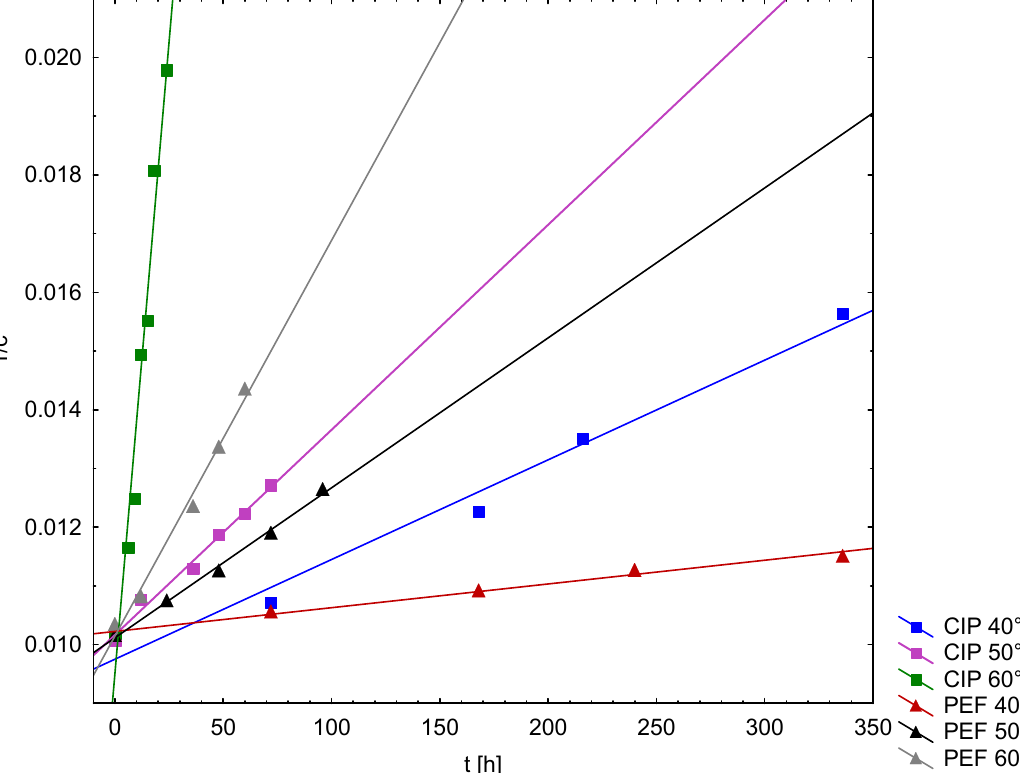
Figure 11 . The 1/c = f(t) graph of oxidation of CIP and PEF solutions under the influence of ACVA. After analysing the data, it was found that oxidation of CIP and PEF under the influ- ence of ACVA proceeds faster with increasing temperature. At all examined temperatures of the experiment, there were significant differences in the rate of oxidation reaction for CIP and PEF solutions. The estimated kinetic parameters of the CIP oxidation process un- der the influence of ACVA indicate that, for all tested temperatures, it runs faster than for PEF solutions (Table 3). The oxidation of CIP at 60 °C was about 5.9 times faster than that of PEF. In the case of PEF, oxidation under the influence of ACVA at 40 °C was about 4.2 times slower than for CIP under the influence of ACVA (Table 3). 3.4. Identification of Oxidation Products Based on the UHPLC-MS/MS technique (corresponding chromatograms and MS spectra are shown in Supplementary Materials section Figures S2–S5), the structures of the main oxidation products of the examined FQs were proposed and supported by